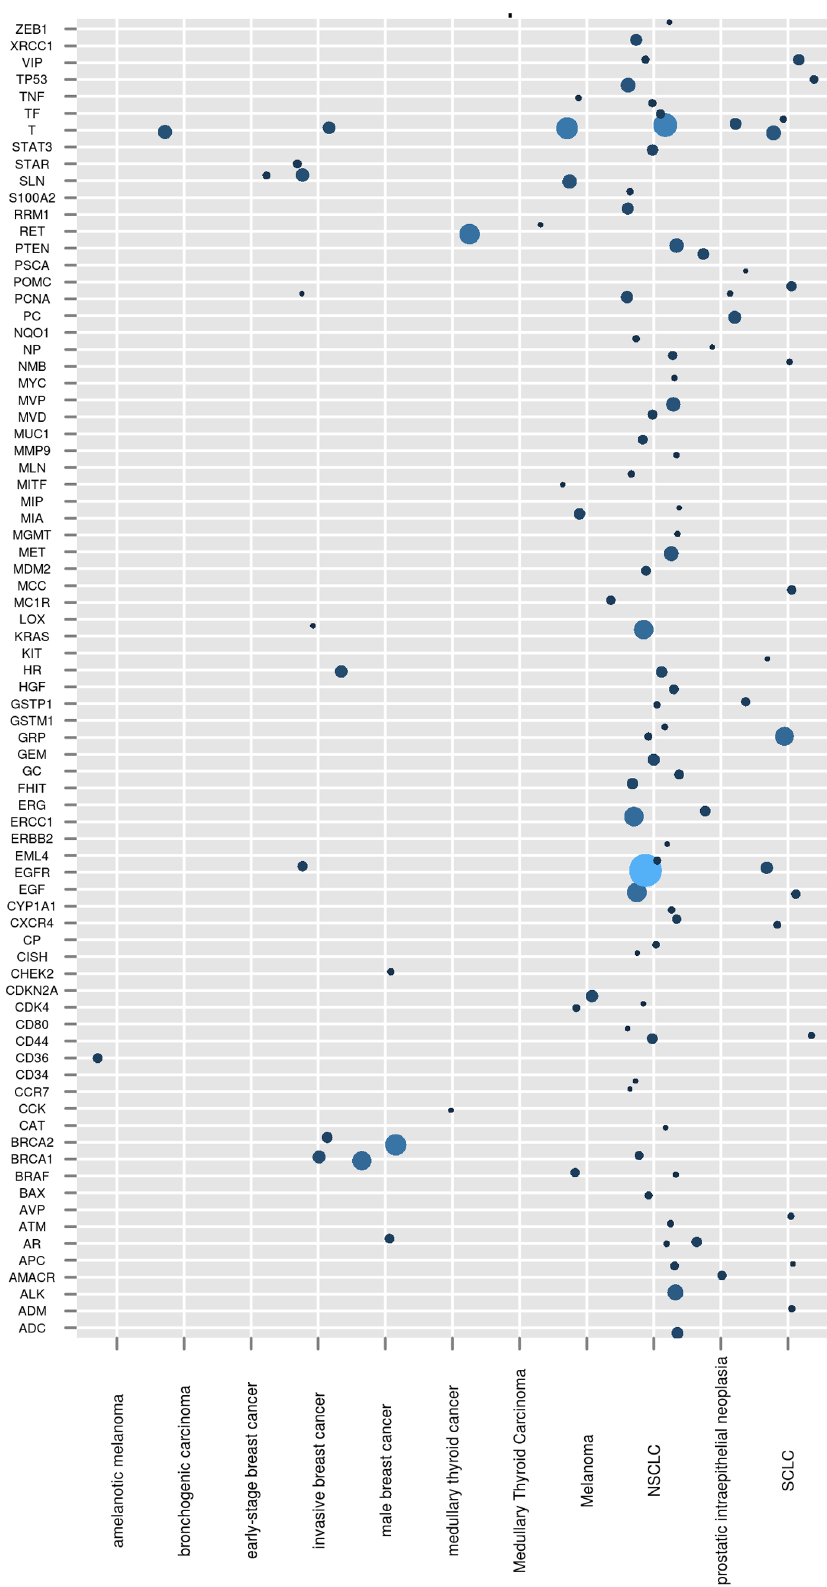
Figure 2. Bubble chart of Cancer-Gene associations from literature. A bubble chart representation with cancer terms on the x-axis and genes on the y-axis. The size of the bubble is directly proportional to the number of literature articles where the cancer and gene terms co-occur.